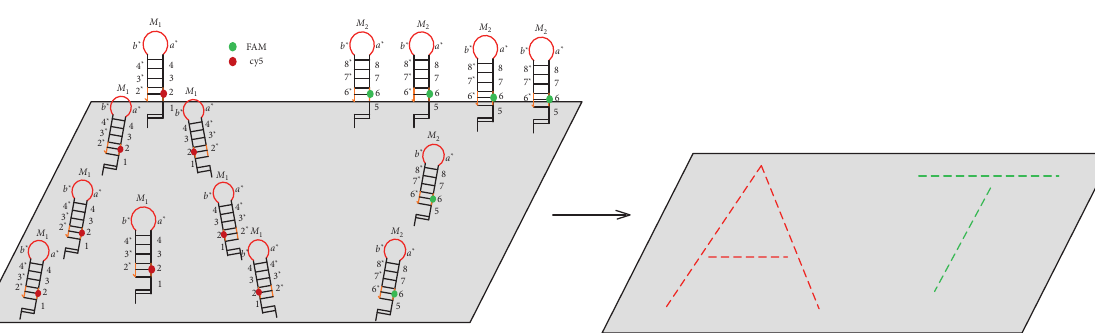
Figure 11: The case of NAND gate input (0, 0).